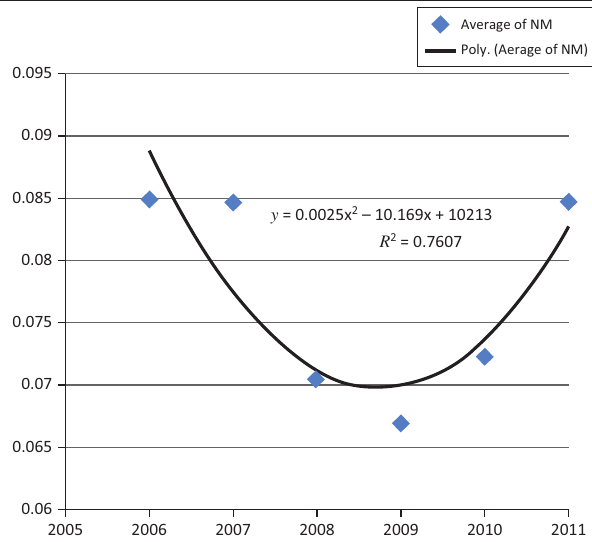
FIGURE 2: Leverage (mean).